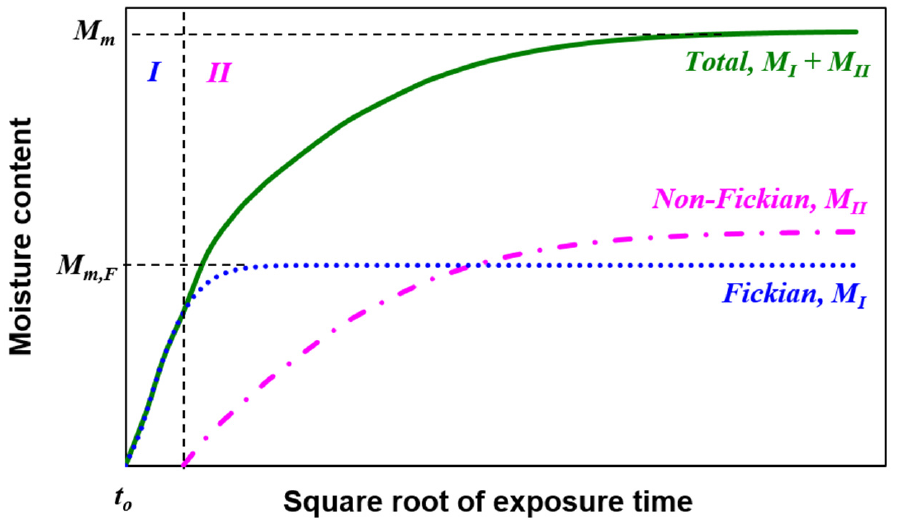
Figure 2. Moisture absorption distribution of the thickness-dependent moisture absorption model. In Equation (1), M m means the maximum moisture content of each specimen, D z refers to the Fickian diffusivity of the material, h indicates the thickness of the specimens, and t is any instant of the immersion time. Additionally, φ represents the ratio of the maximum moisture content at Stage I to the total maximum moisture content of the specimen ( φ = M m,F /M m ), α is the non-Fickian diffusivity per square thickness, and t o indicates the initiation time of Stage II. The Macaulay bracket, < > for the time delay term, < t − t o >, depicts that non-Fickian behavior only occurs after t ≥ t o . For this model to be applicable, Stage I of the experimentally reduced moisture absorption curves ( M vs. at all thicknesses must overlap. This behavior is observed because Stage I is assumed to exhibit Fickian diffusion